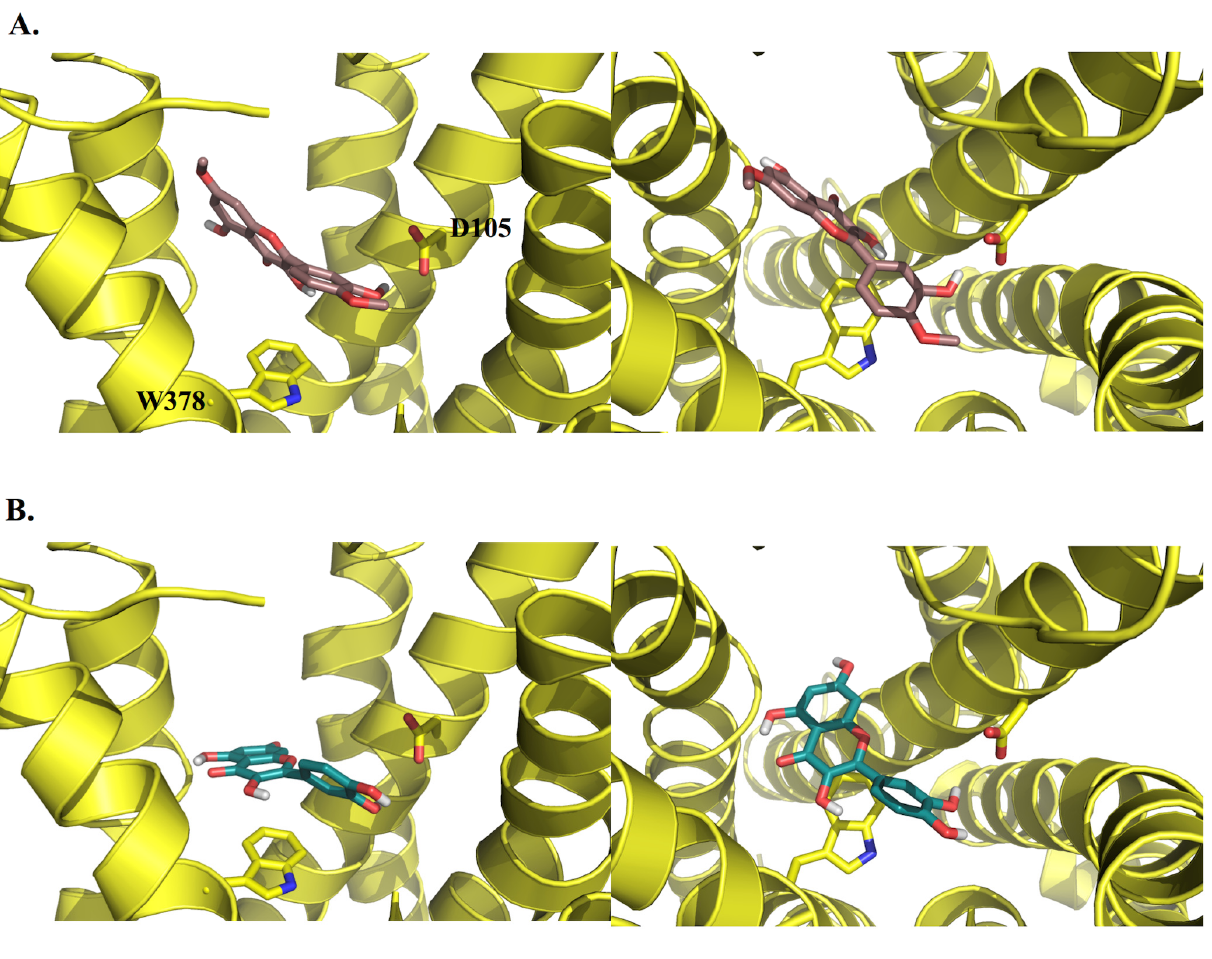
Figure 3. 3D representations of the docking poses of ( A ) ombuin ( 9 ) (brown) and ( B ) quercetin ( 12 ) (blue-green) in complex with the human M from induced-fit docking using Glide v5.7 and Prime v3.0 (Schrödinger LLC) with side views and top views (from the extracellular surface) depicted in the left hand and right hand panels, respectively. For the purpose of clarity, only D105 and W378 from among the active site residues are depicted in stick representation and some of the transmembrane helices are not